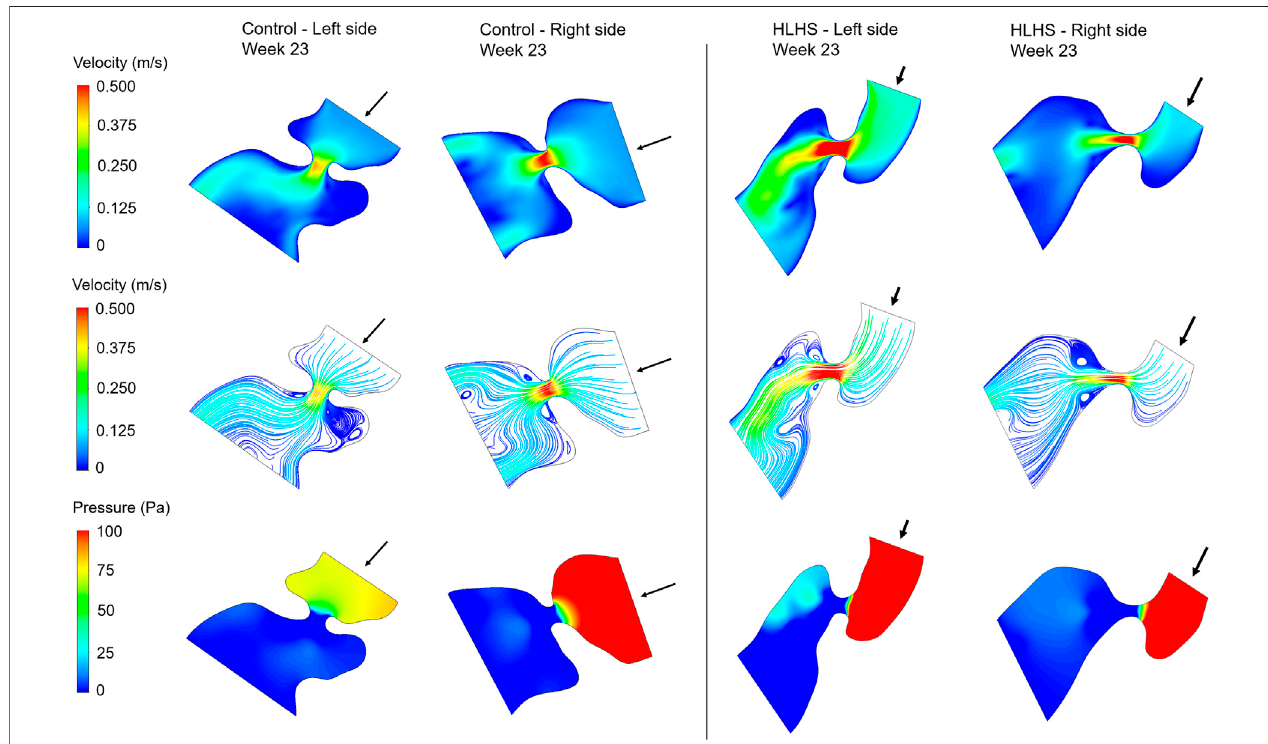
FIGURE 7 | Velocity contours, fl ow streamlines, and pressure contours at the instant of peak inlet fl ow rate for 23-week control and HLHS hearts. The arrows indicate the fl ow direction at the inlet.